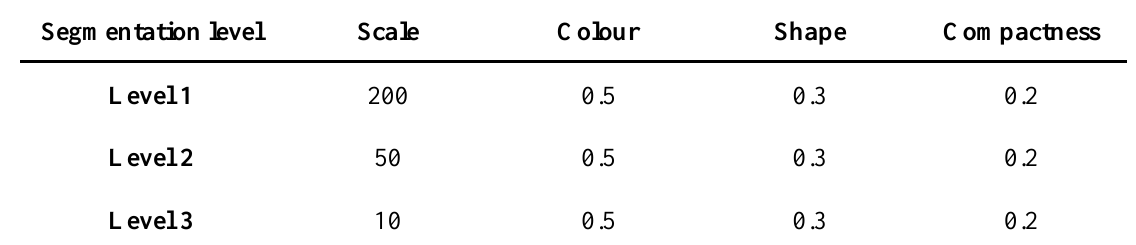
Table 3. Segmentation parameters assigned in the current paper.